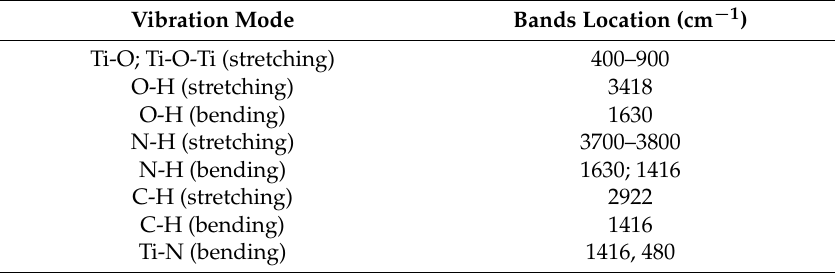
FTIR vibration bands and their locations for CDT-0.00, CDT-300, CDT-400, and CDT-500